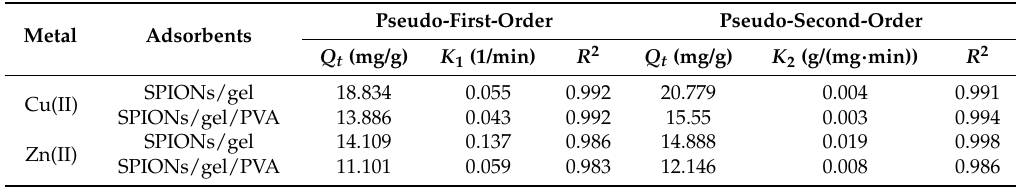
Table 1. Adsorption kinetic parameters for adsorption of Cu(II) and Zn(II) on SPIONs/gel and SPIONs/gel/PVA.